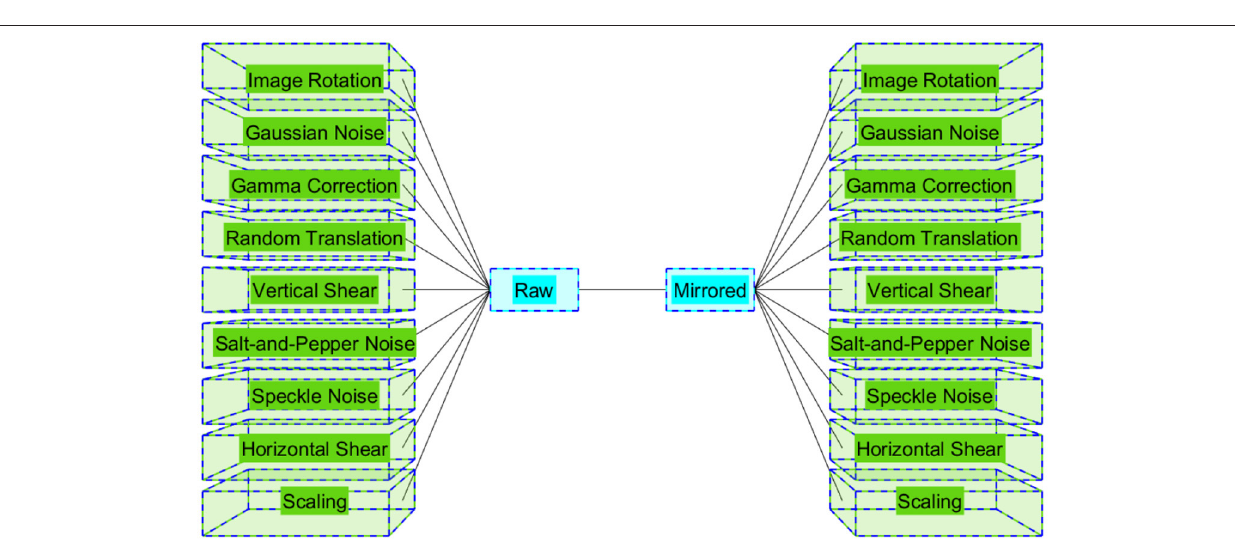
FIGURE 7 | A diagram of 18-way